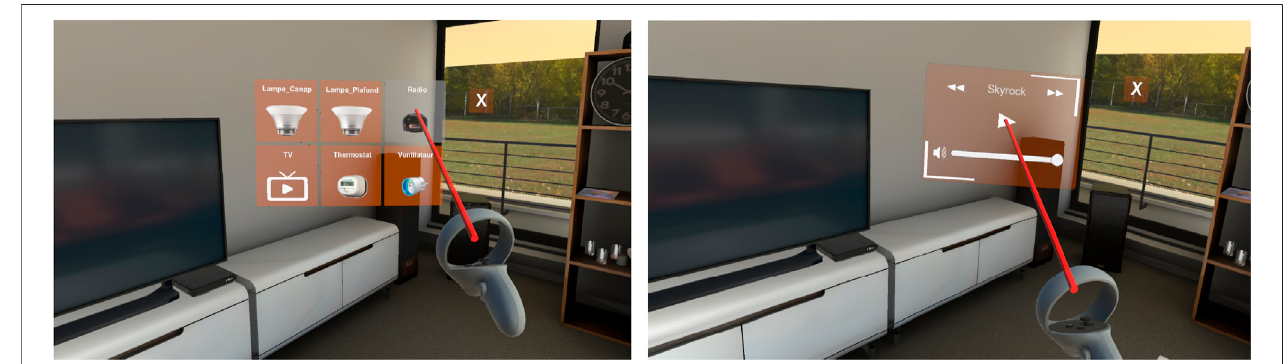
FIGURE2| Thedashboardinteractionmode.Ontheleftthedashboarddisplaystheiconsofthesixconnectedobjectsoftheroom.Ontheright,whentheiconofa connected object is clicked, its associated user interface is displayed on the dashboard. Here it corresponds to the interface to control the radio.